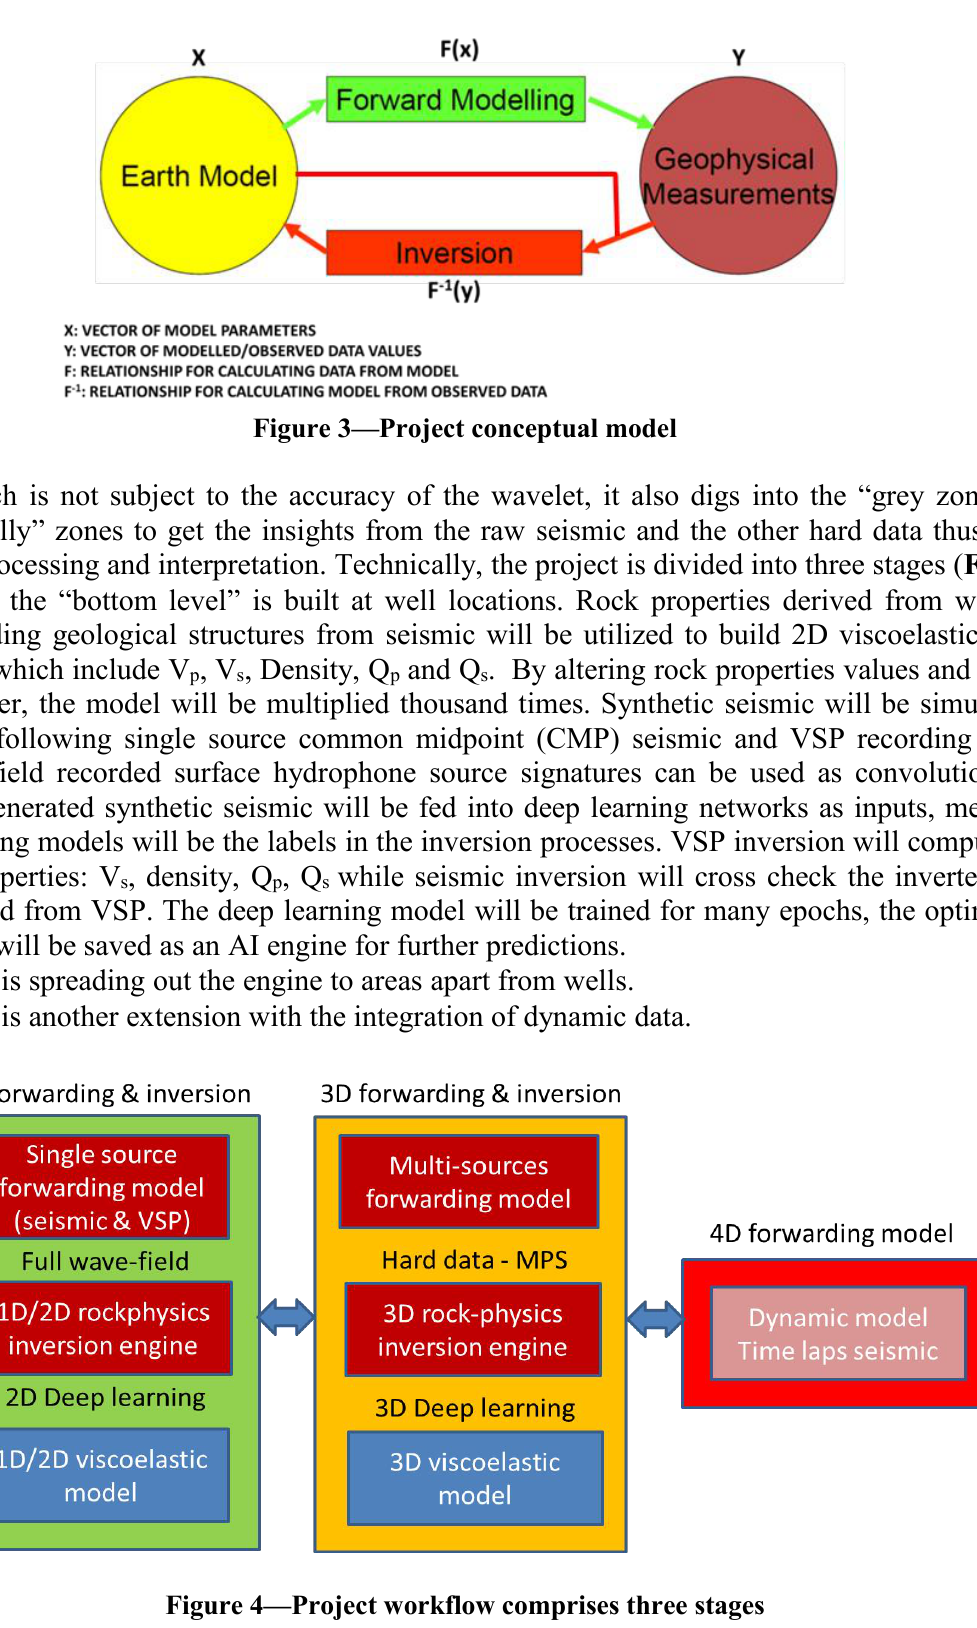
Figure 4—Project workflow comprises three